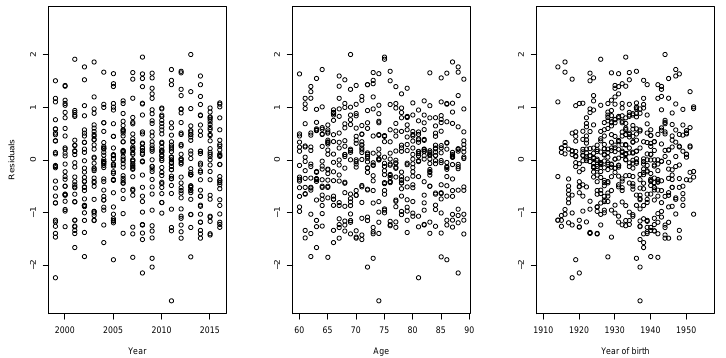
Figure 12. Plat–LC deviance residuals for the male Maltese population.